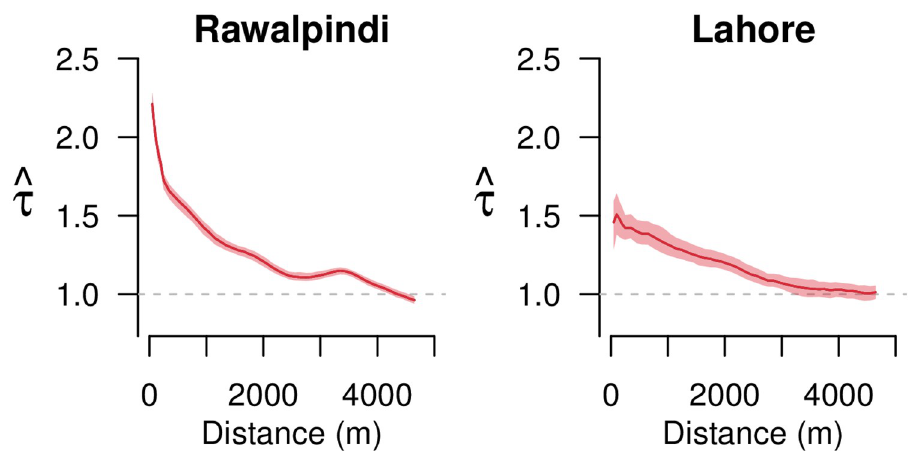
Fig 2. Spatial dependence of cases in Rawalpindi and Lahore. Spatial dependence of cases occurring within 30 days of index cases in Rawalpindi and Lahore. The spatial window of the analysis ( d 2 minus d 1 ) is maintained at 500 m when d 2 is greater than 500 m, and observations are made by sliding the window at intervals of 100 m. For d 2 less than 500 m, d 1 is equal to zero and observations are made by increasing d 2 at intervals of 100 m. Spatial dependence estimates are plotted at midpoint of the spatial window. The time window t 2 − t 1 is set to 30 days. 95% CI is shown as shaded area around